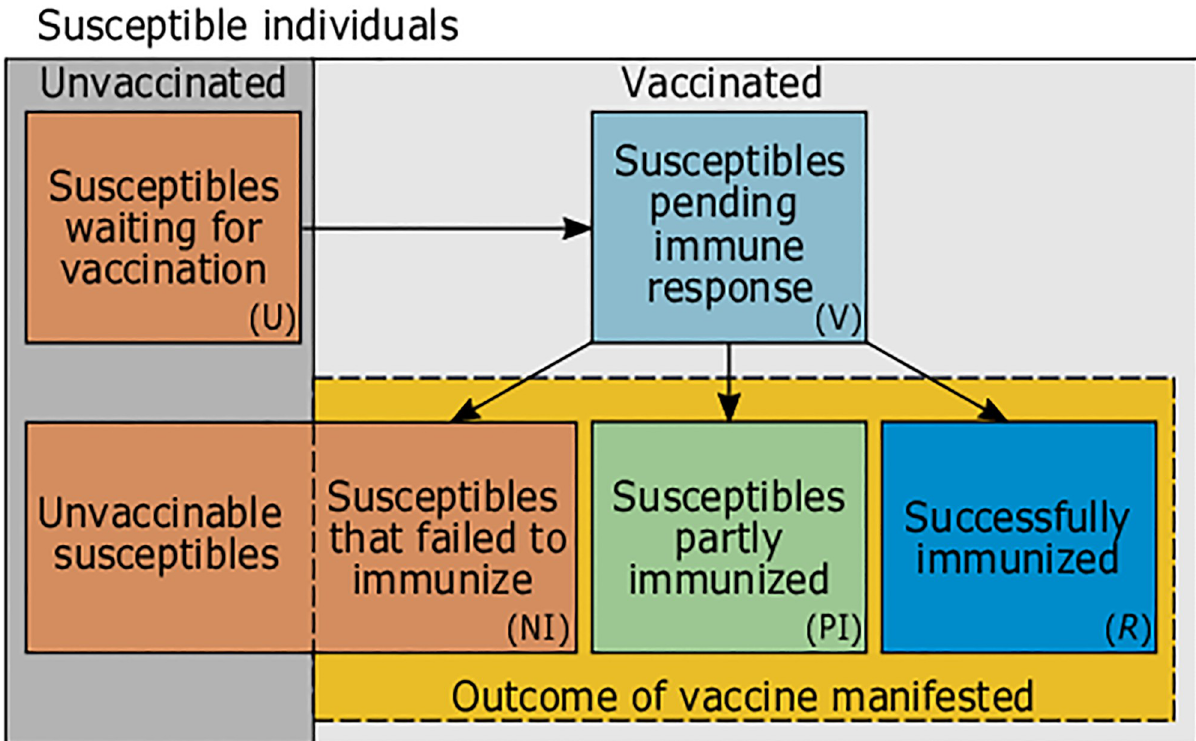
Fig 2. Subdivision of susceptible individuals. Susceptible individuals are subdivided by their vaccination status. Each ‘class’ of susceptible individuals is further stratified by age and location (not illustrated).